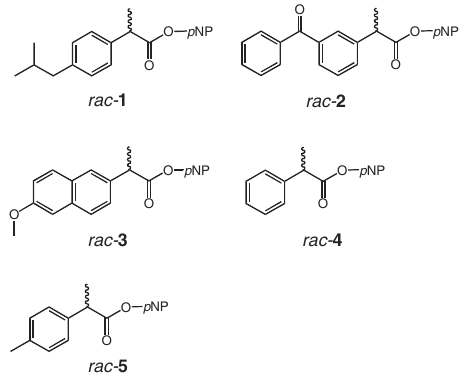
Fig. 3 Chemical structures of rac - 1 – 5 . Chemical names: rac - 1 , ibuprofen- p NP ester; rac - 2 , ketoprofen- p NP ester; rac - 3 , naproxen- p NP ester; rac - 4 , 2- phenylpropanoate- p NP ester; rac - 5 , 2-( para -methylphenyl)propanoate- p NP ester.